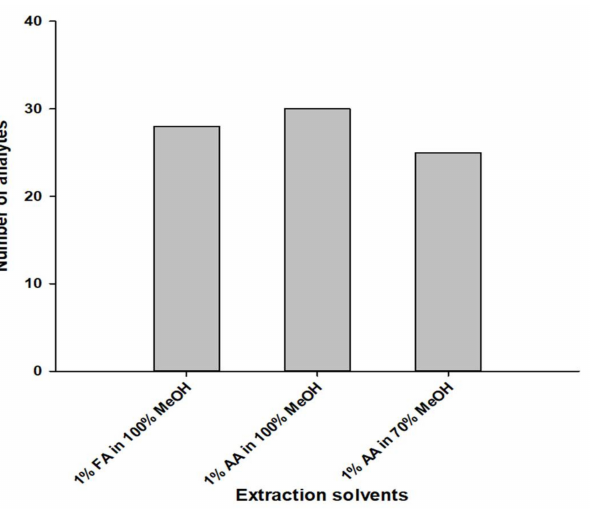
Figure 3. Effect of the different extraction solvents on the recoveries (70~120%) of target compounds at middle validation levels. These conditions included: (1) 1% formic acid (FA) in 100% methanol; (2) 1% acetic acid (AA) in 100% methanol; and (3) 1% AA in methanol/ethyl acetate (70:30, v / v ). All preparations were performed in triplicate using blank pet feed samples ( n =